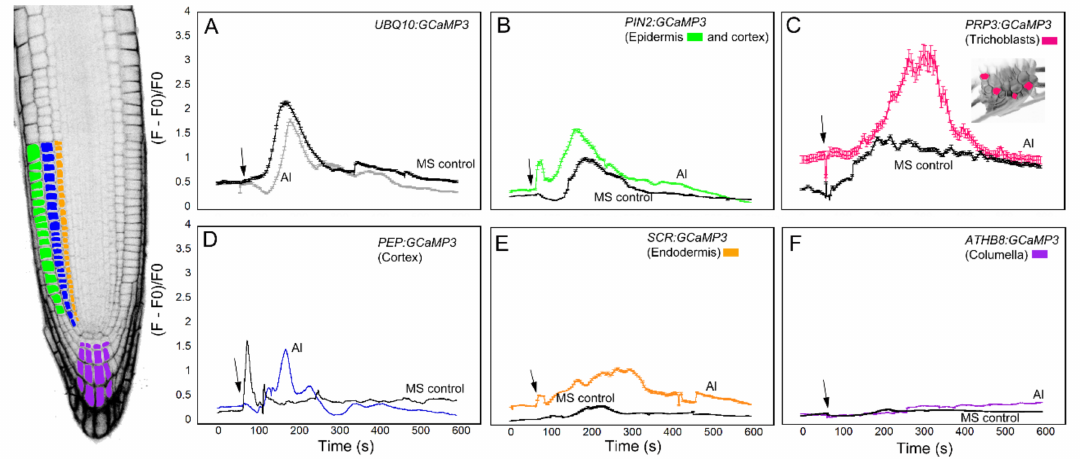
Figure 5. Time course of [Ca 2 + ] cyt changes in A. thaliana roots after 1 mM aluminum (Al 3 + ) chloride application. The leftmost panel shows an inverted fluorescence image of the terminal 300 µ m of an A. thaliana primary root to illustrate di ff erent cell types in which GCaMP3 was expressed. Cell types are color coded with green = epidermis; blue = cortex; orange = endodermis; purple = columella; and the pink cells in the inset in panel C = trichoblast. ( A – F ) Quantification of [Ca 2 + ] cyt -dependent fluorescence of various lines expressing GCaMP3 after Al 3 + and solvent control (0.5 × MS) application. Black arrows indicate the time of treatment. Plotted values represent the average normalized fluorescence intensity from 3–7 regions of interest (ROI) per line with standard error bars every fifth time point. Fluorescence values were normalized to the lowest fluorescence